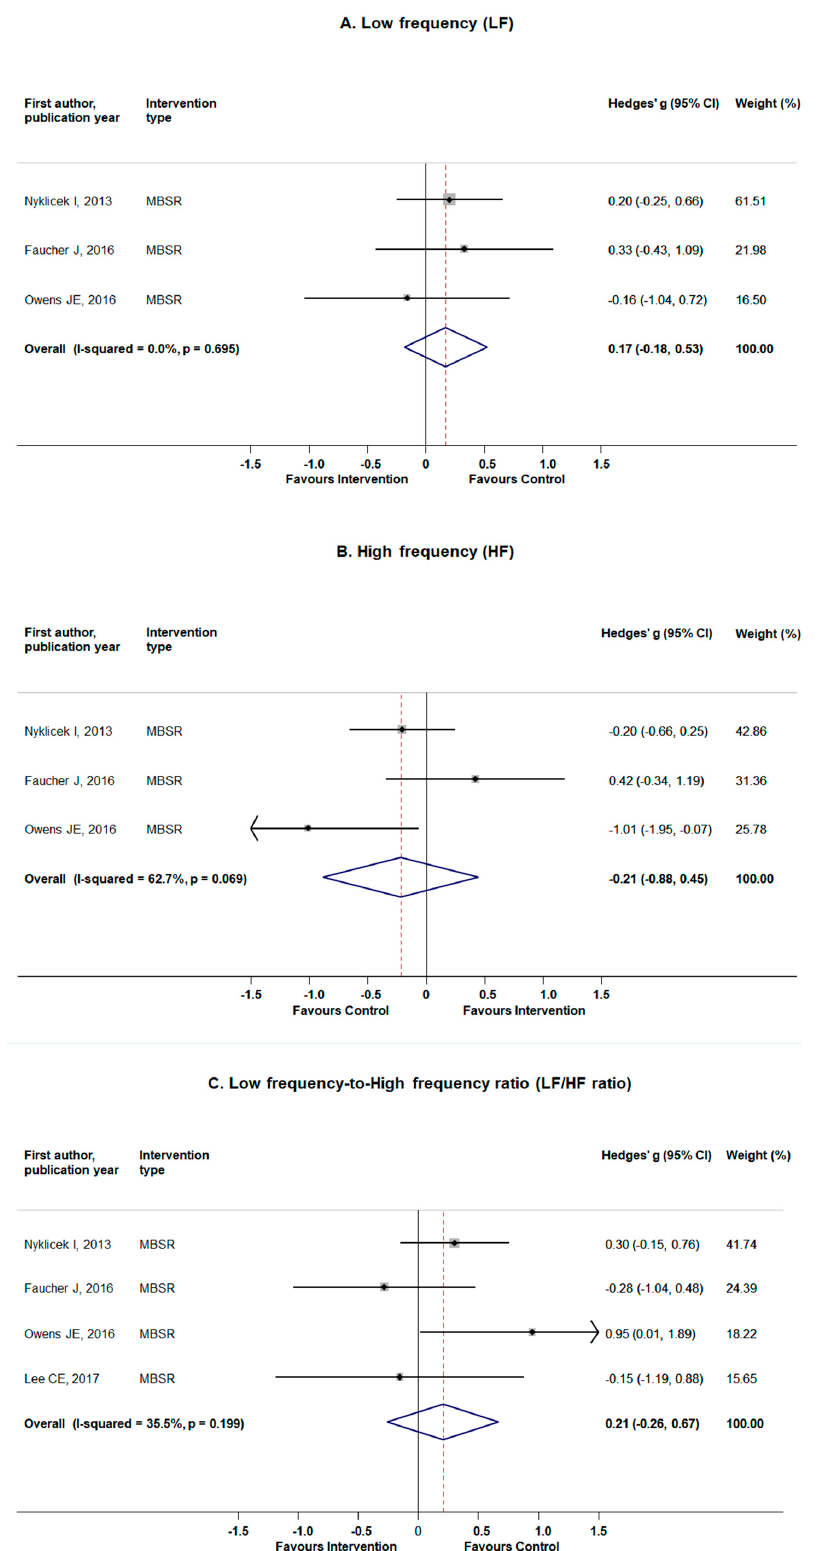
Figure 4. The e ff ects of standardized mindfulness-based interventions on frequency domain heart rate variability (HRV) parameters: low frequency (LF) (panel A ), high frequency (HF) (panel B ), and LF / HF ratio (panel C ). Squares indicate standardized di ff erence in means (Hedges’ g) and lines represent 95% confidence intervals (CI); the size of the box represents the weight of each